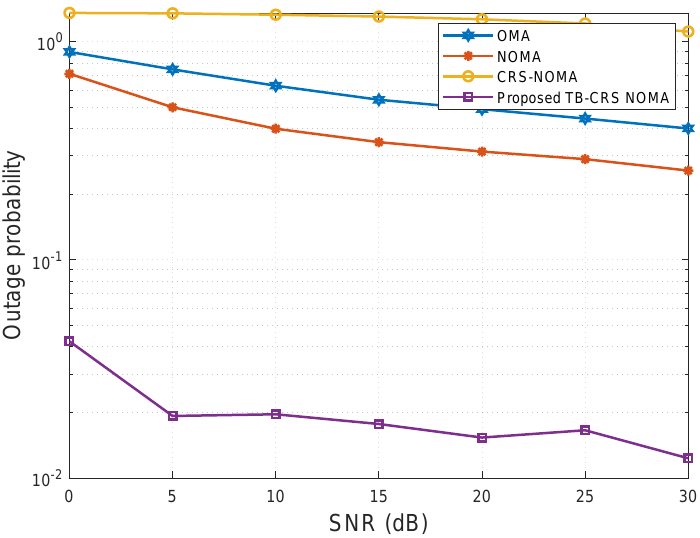
Figure 10. Outage probability versus SNR for K = 32